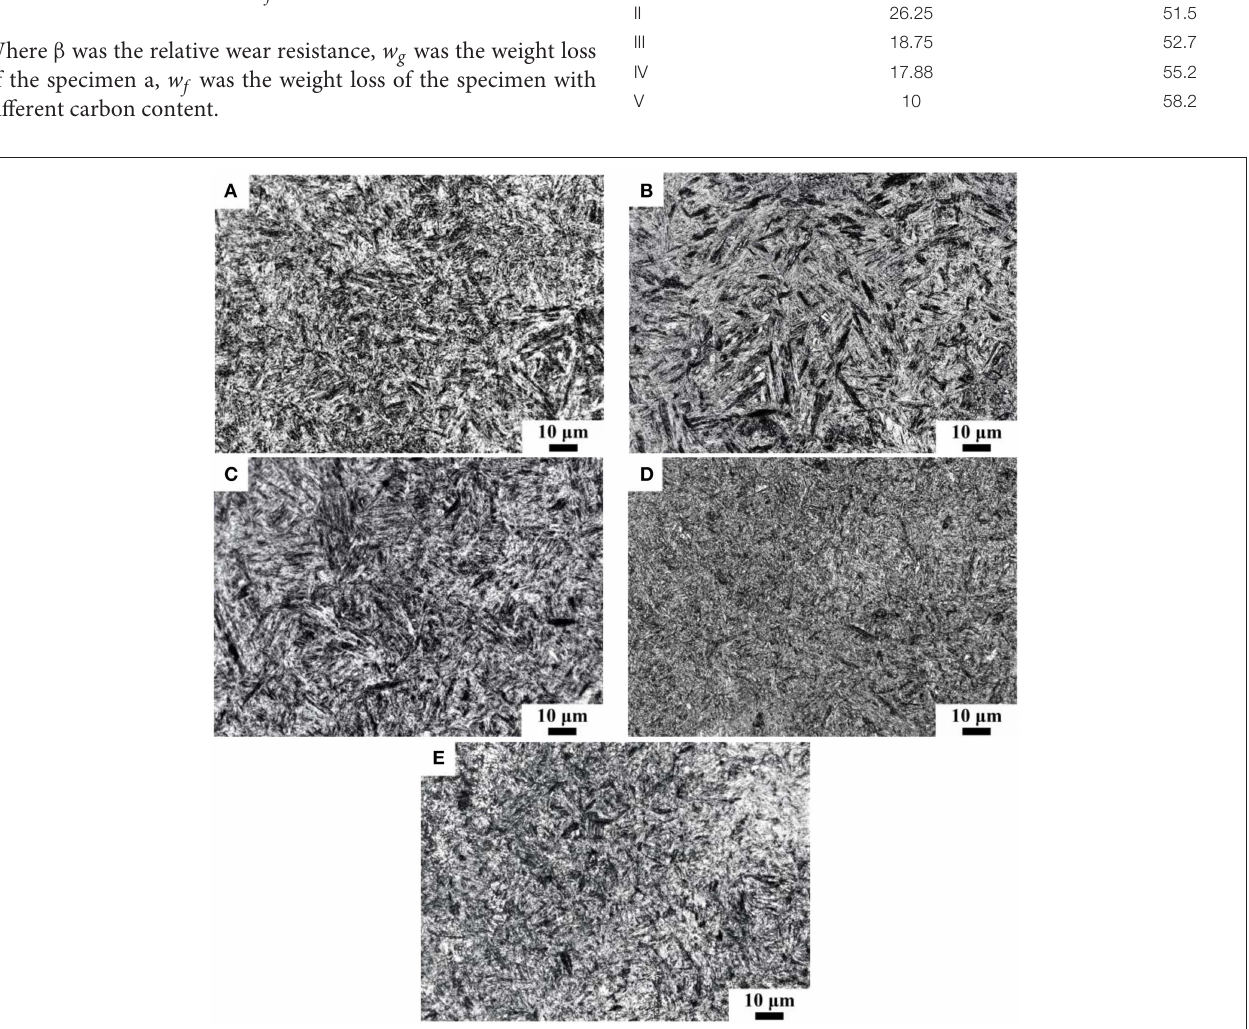
Frontiers in Materials |